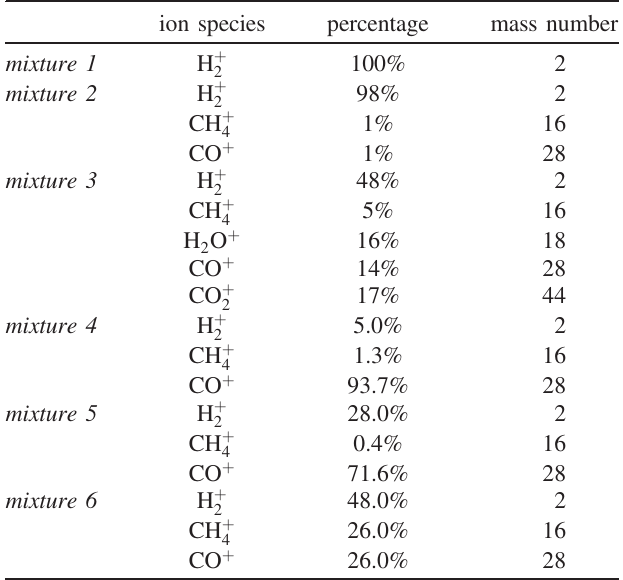
TABLE II. Mixtures of ionized residual gas used for the simulations.